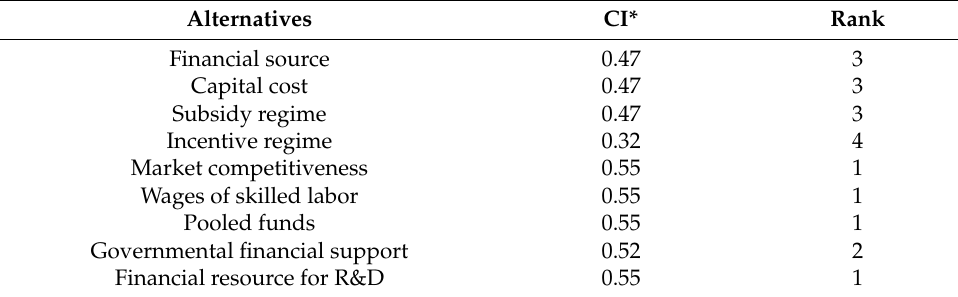
Table 8. Ranking of alternatives economic